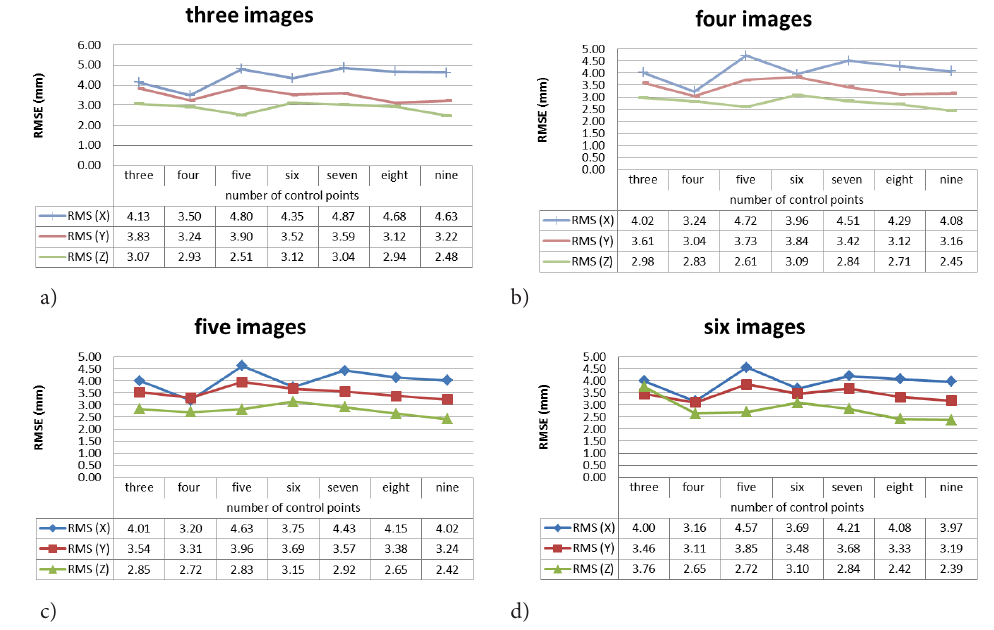
Figure 8. The results of RMS residual errors using metric camera with photogrammetry scanner